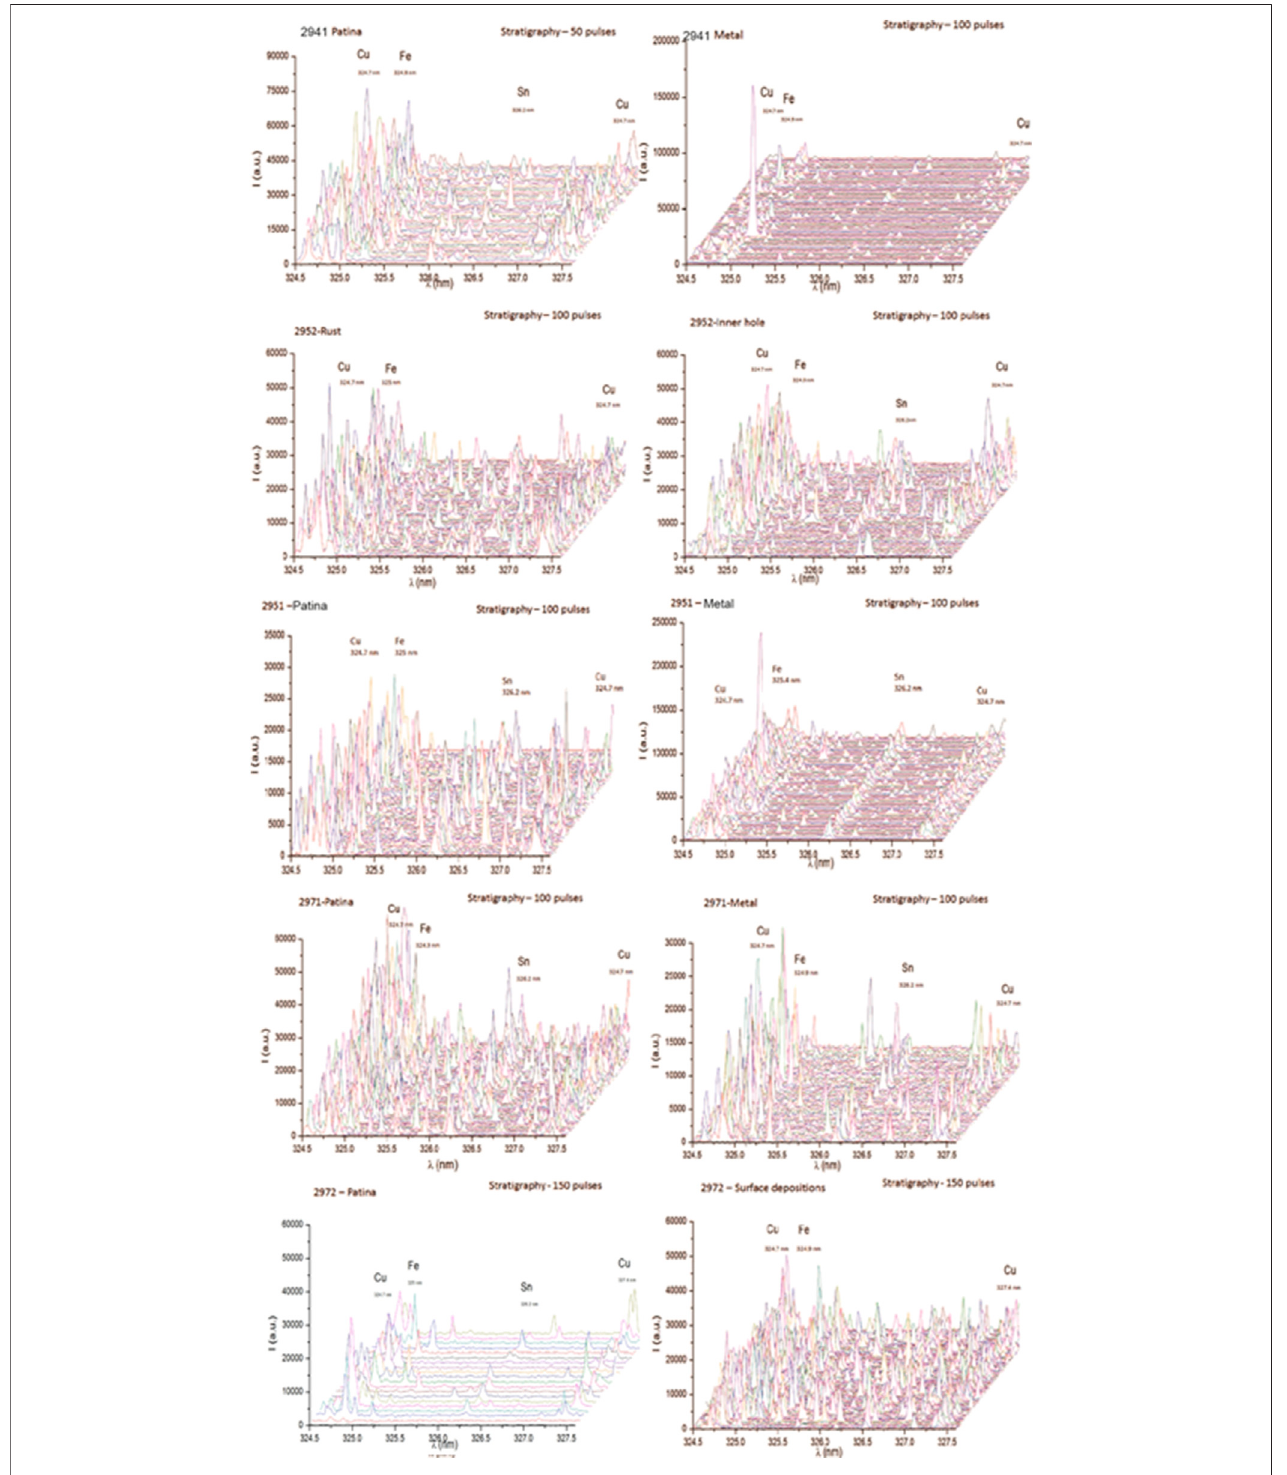
FIGURE 7 | LIBS spectra of the bronze adornments.